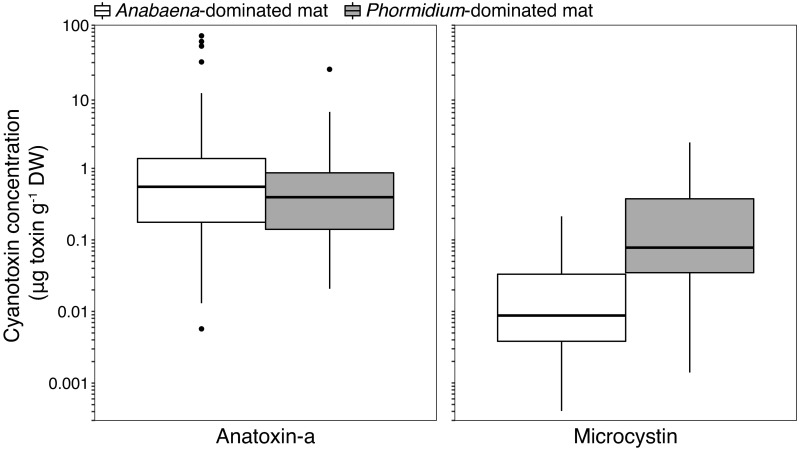
Boxplots of intracellular anatoxin-a and microcystin concentrations from cyanobacterial mats dominated by Anabaena (n = 116) or Phormidium (n = 62) collected in 2014 and 2015.Only samples with cyanotoxin concentrations above the detection limit are included in the boxplots. For anatoxin-a, there were 69 Anabaena-dominated and 36 Phormidium-dominated samples above the detection limit, and for microcystin there were 31 Anabaena-dominated and 36 Phormidium-dominated samples above the detection limit. The boxplots are plotted on a log10 scale, and the box represents the 25th percentile, median, and 75th percentile of the data, the whiskers extend up to 1.5x the interquartile range, and points beyond the whiskers are plotted individually.